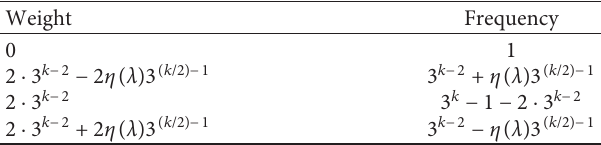
S 0 for Theorem 2 (i).